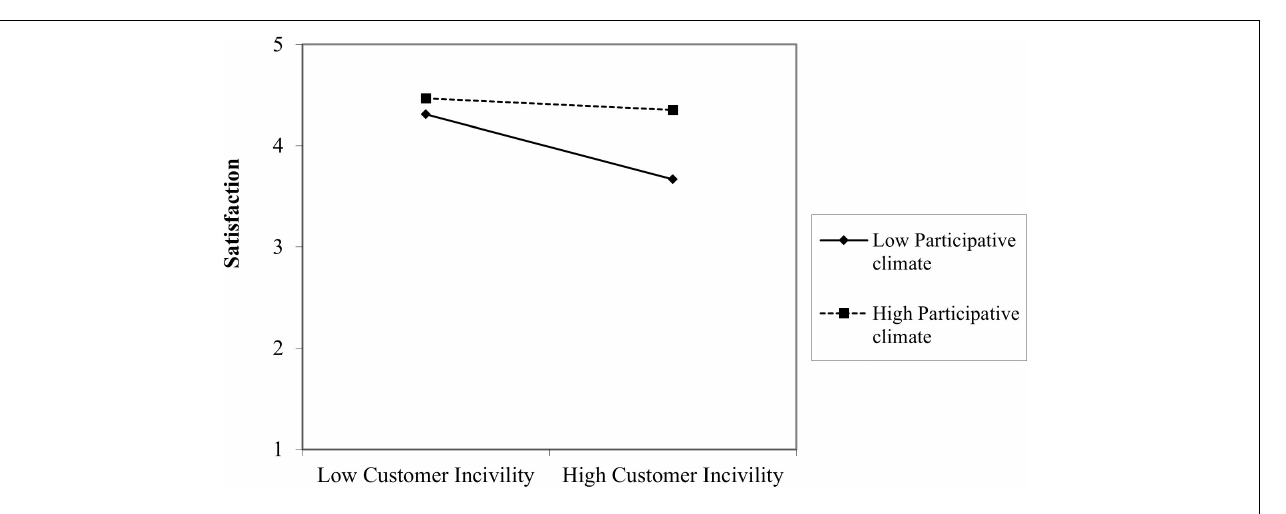
FIGURE 2 | Level 1 interaction between perceived customer incivility and supervisor support.